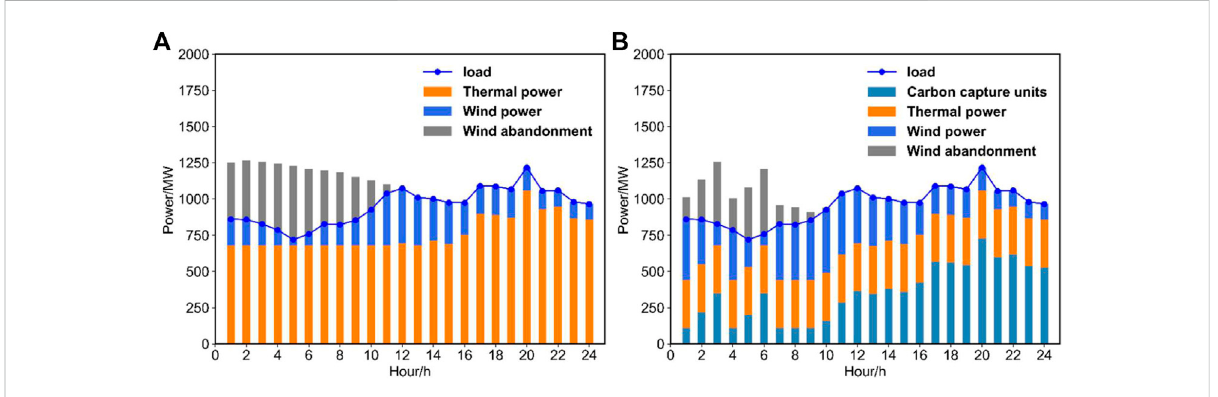
FIGURE 12 Day-ahead dispatch resultswith andwithoutcarboncapturedevices( (A) iswithout carboncapturedevices, (B) iswith carboncapturedevices).